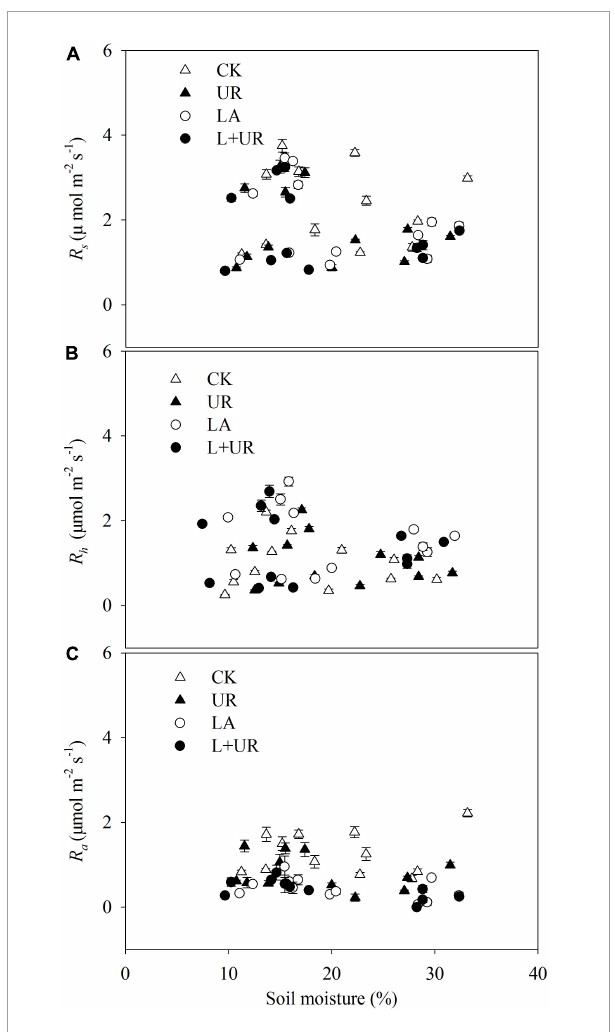
FIGURE6 (A–C) Are Soil respiration ( R s , R h , and R a ) in relation to soil moisture at 5 cm depth across the four treatments,